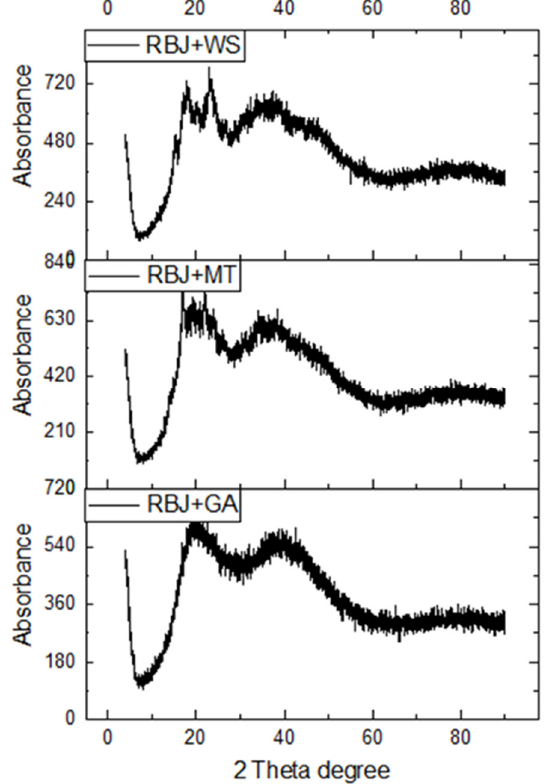
Figure 6. XRD spectra of raspberry juice powders developed using different carriers. WS—waxy starch; MT—maltodextrin; GA—gum Arabic.; RBJ—raspberry juice.